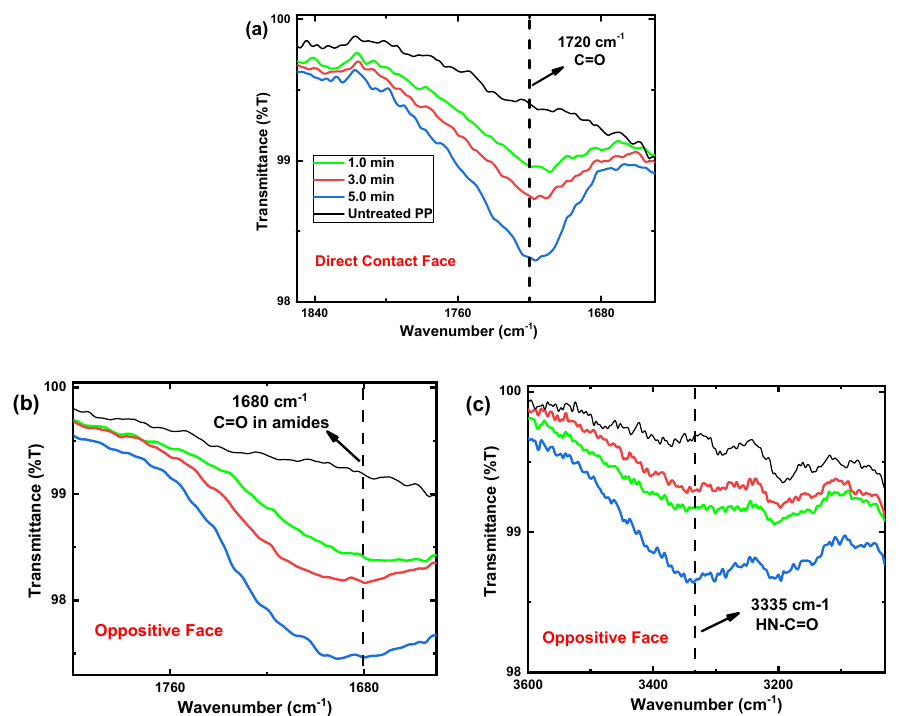
Figure 5. FTIR spectra of polypropylene samples untreated, and treated by 1.0, 3.0, and 5.0 min. ( a ) DCF in the region between 1850 to 1650 cm − 1 ; ( b ) OF in the region between 1800 to 1650 cm − 1 ; and ( c ) OF in the region between 3600 to 3000 cm − 1 .